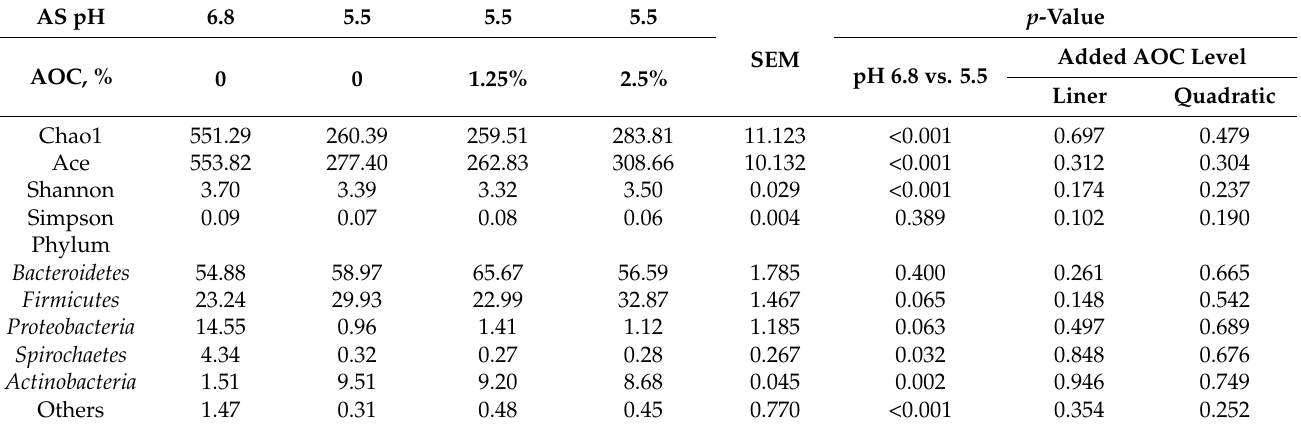
Table 6. The effect of AS pH and supplementation of AOC on rumen bacteria at the phylum in RUSITEC